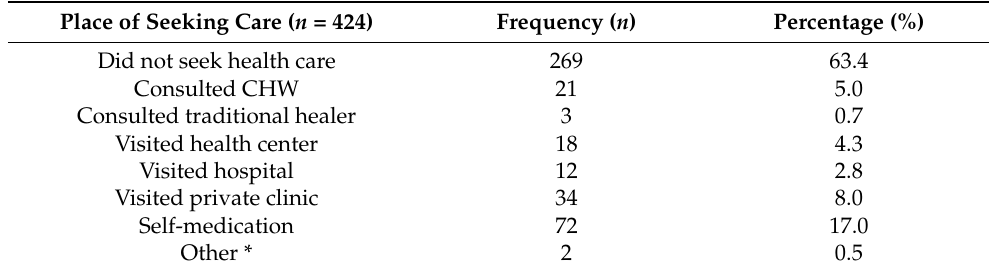
Table 2. Health care seeking following AstraZeneca side-effects.